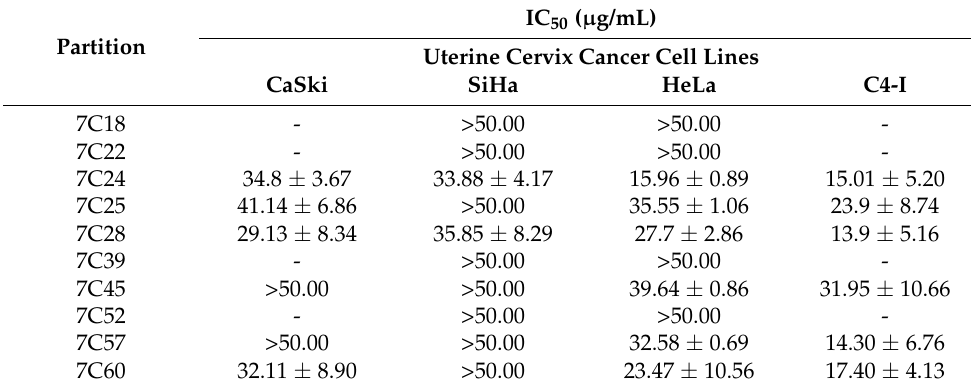
Table 5. IC 50 values 1 of A. crassiflora fractions in cervical cancer cells.